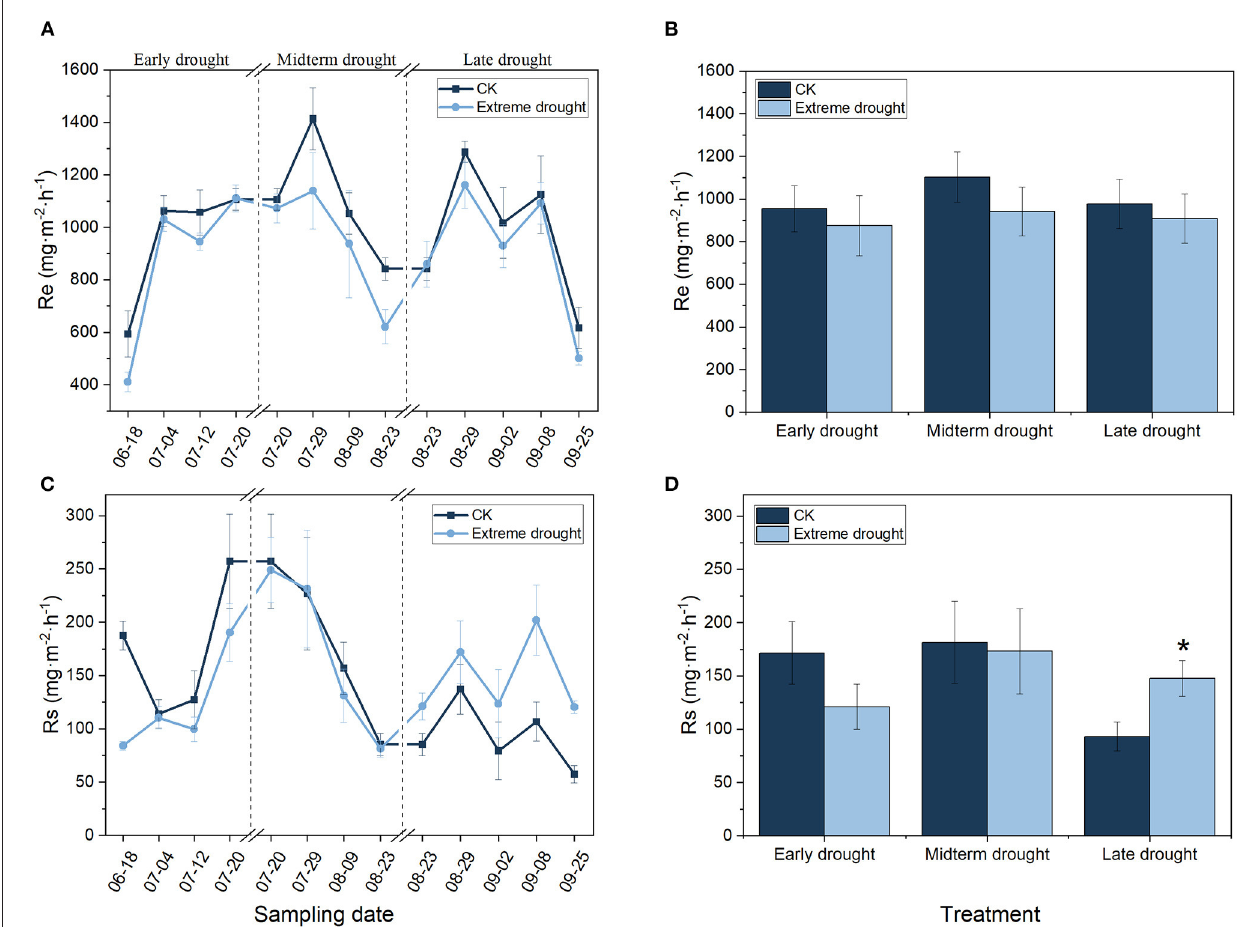
TABLE 3 | The effects of different periods of extreme drought treatment, sampling time, and relevant interactions on ecosystem respiration (Re) and soil respiration (Rs) in 2019. Variance source Early drought Midterm drought Late drought df Re Rs